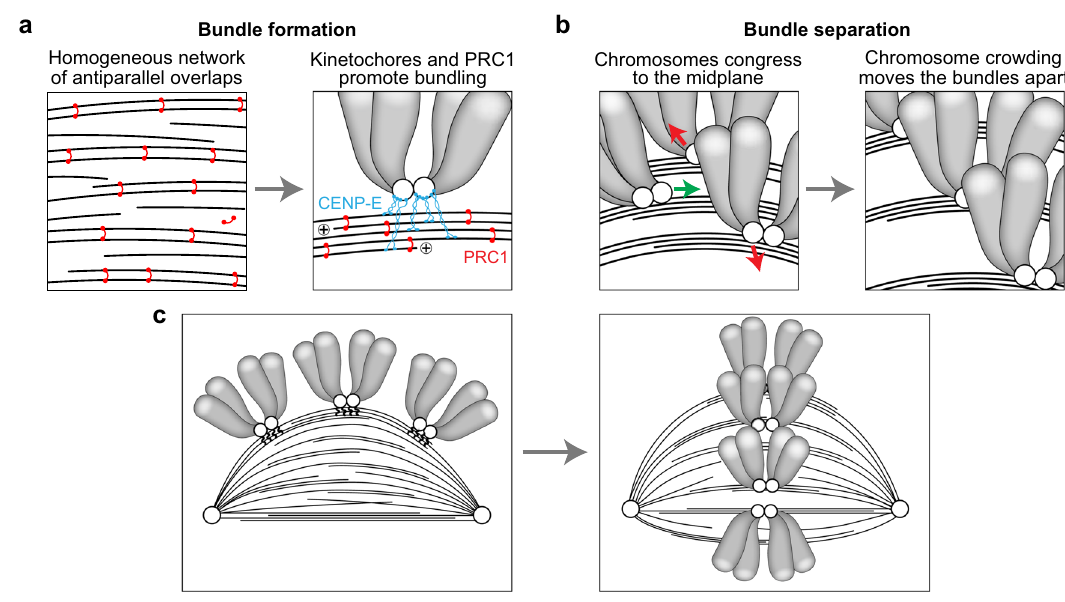
Fig. 7 | Model for kinetochore-driven overlap formation. a A loose microtubule network consisting of uniformly distributed antiparallel overlaps linked by PRC1 (red) undergoes a transition to tight bundles due to the microtubule-binding activityofkinetochores(CENP-E,blue). b Bundlesareseparated(redarrows)during chromosome congression(green arrow) to the spindlemidplane and steric effects